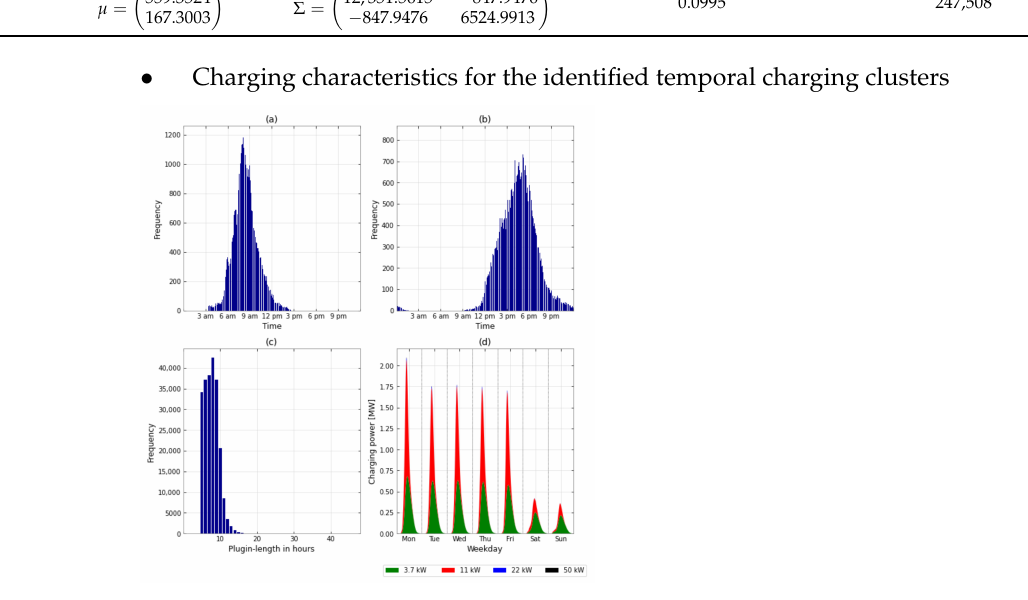
Figure A3. Charging characteristics of temporal charging cluster 1: ( a ) Frequency of different plug-in times; ( b ) Frequency of different plug-out times; ( c ) Frequency of different plug-in lengths; ( d ) Charging power used.